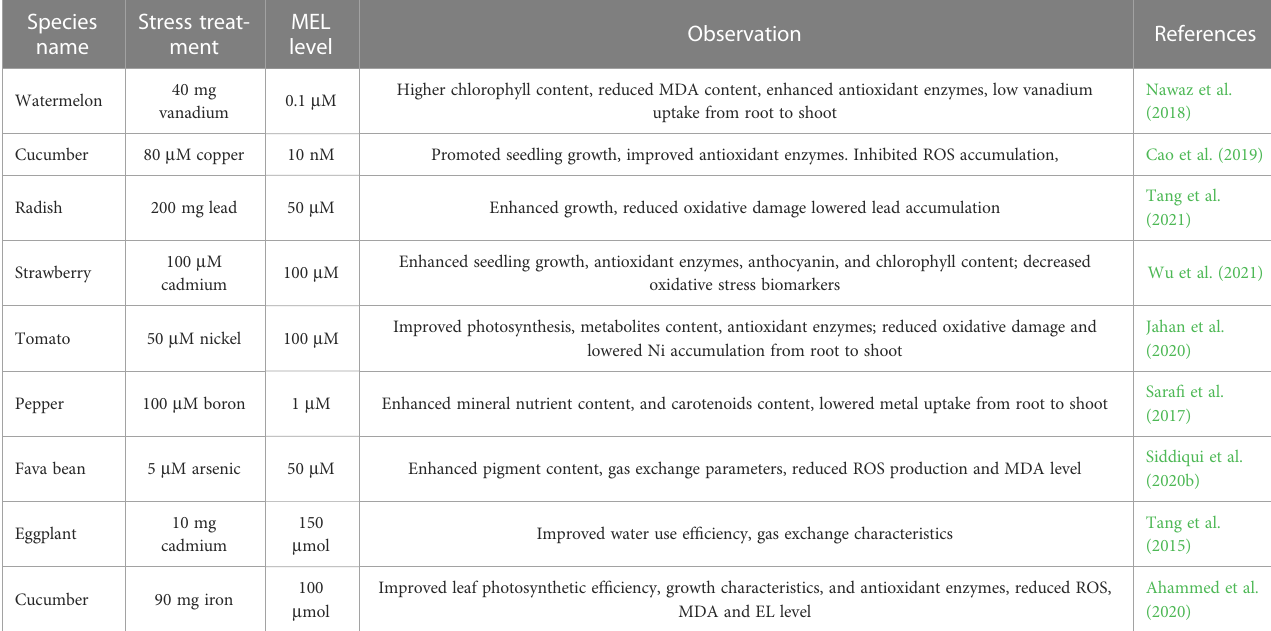
TABLE 5 Melatonin mitigates heavy metals toxicity in horticultural plants.